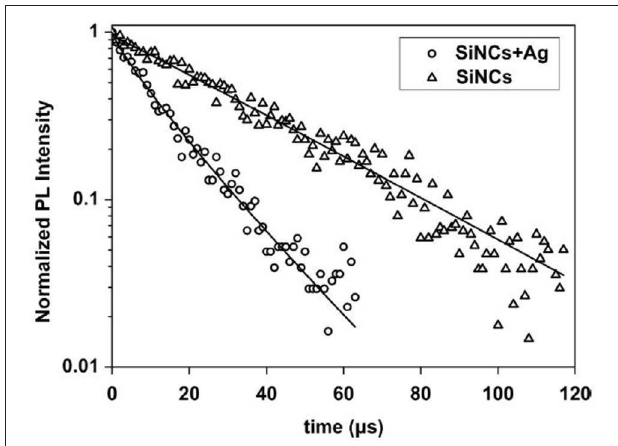
FIGURE 6 | Comparison of the decay times of microporous samples containing Ag particles and samples without Ag. Gardelis et al. [58], Elsevier by